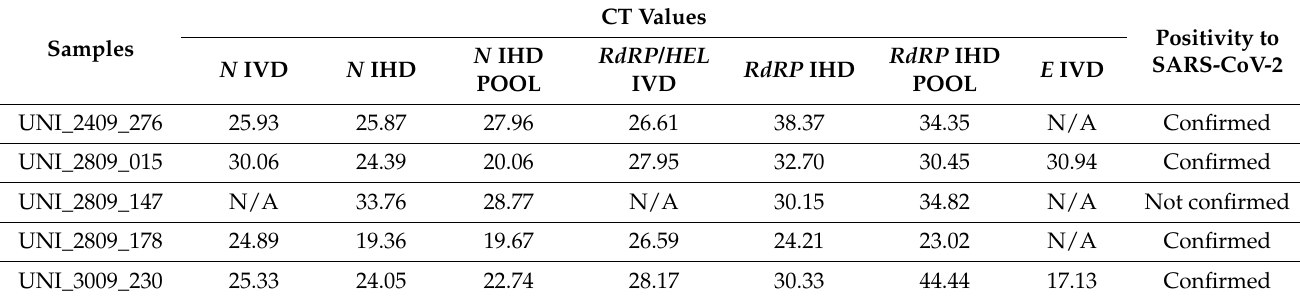
Table 2. Comparison of Ct Values for SARS-CoV-2 targets in samples analyzed with IVD, IHD and IHD-pooled multiplex RT-qPCR